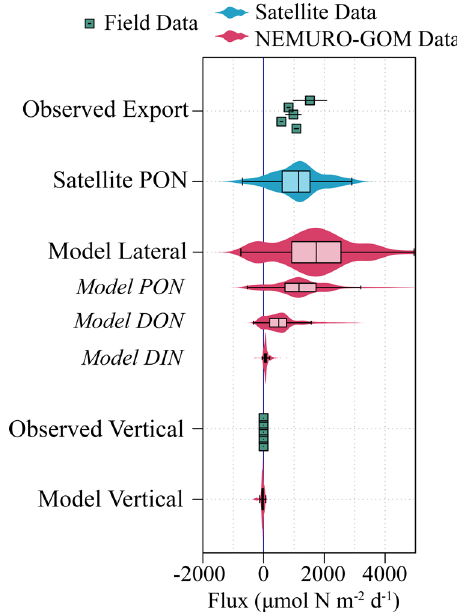
Fig. 3 Comparison of lateral nitrogen supply to observed export production in the upper euphotic zone. Satellite lateral particulate organic nitrogen (PON) fl ux was calculated from 8-day composite Moderate Resolution Imaging Spectroradiometer (MODIS) Terra/Aqua imagery during the month of May (2002 – 2019) with fl ow fi elds prescribed by OSCAR circulation. NEMURO-GOM fl uxes were calculated separately for each nitrogen pool (italicized) and summed for total lateral fl uxes. NEMURO-GOM vertical fl uxes are integrated for the upper euphotic zone and include upwelling and turbulent mixing but not export by sinking particles. Positive fl ux values indicate net input into the integration volume. Flux values are normalized to lateral area. Boxes were determined from the 25 th , 50 th , and 75 th percentile of the data, with whiskers indicating the